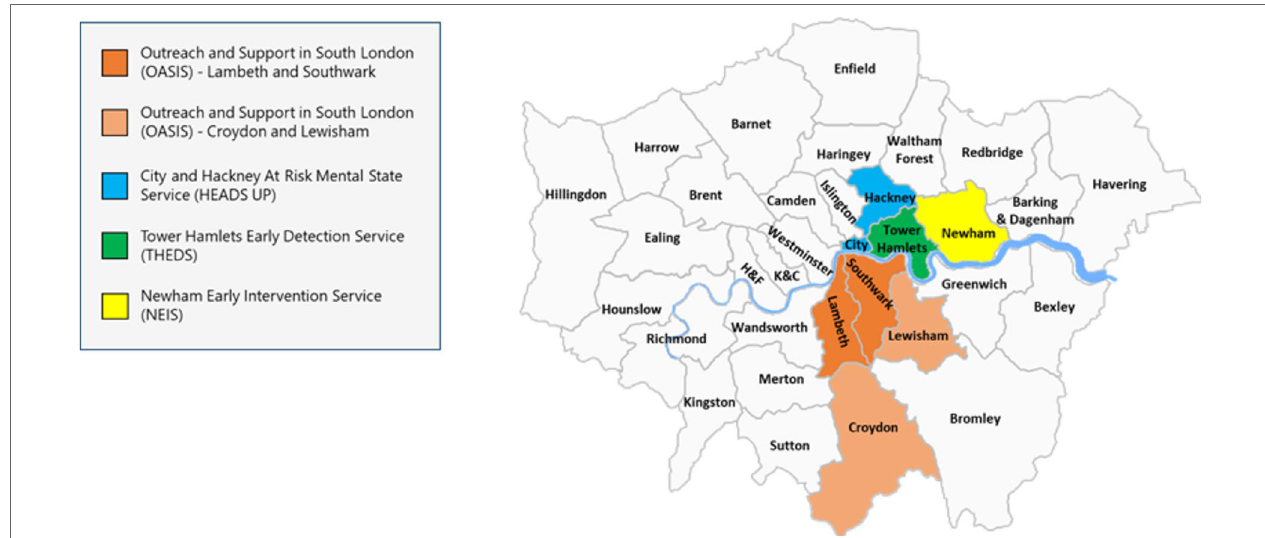
FIGURE 1 | Pan-London Network for Psychosis-Prevention (PNP). Luton and Bedfordshire services were not included. K&C, Kensington and Chelsea; H&F Hammersmith and